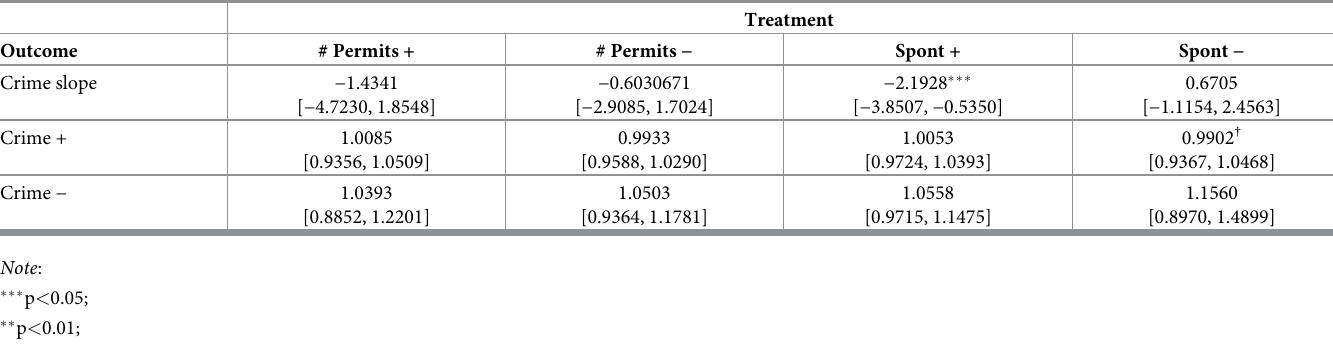
Table 2. Average within-pair differences between the treatment and control groups (and 95% confidence intervals) for all twelve combinations of four treatment variables (columns) and crime outcomes (rows). For the “crime slope” outcome, the difference between slopes is provided, whereas for the “Crime +” and “Crime − ” indicators, the odds ratio is